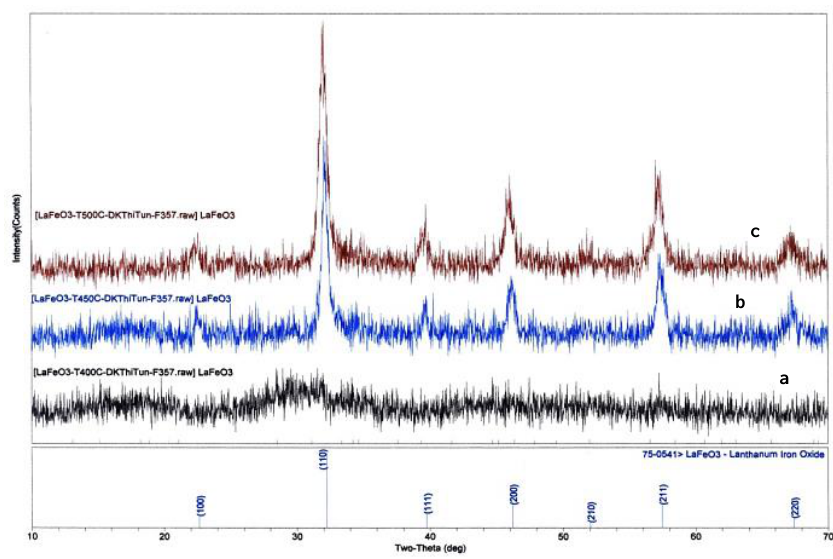
Figure 3. XRD patterns of LaFeO 3 particles calcined at (a) 400 °C (b) 450 °C (c) 500